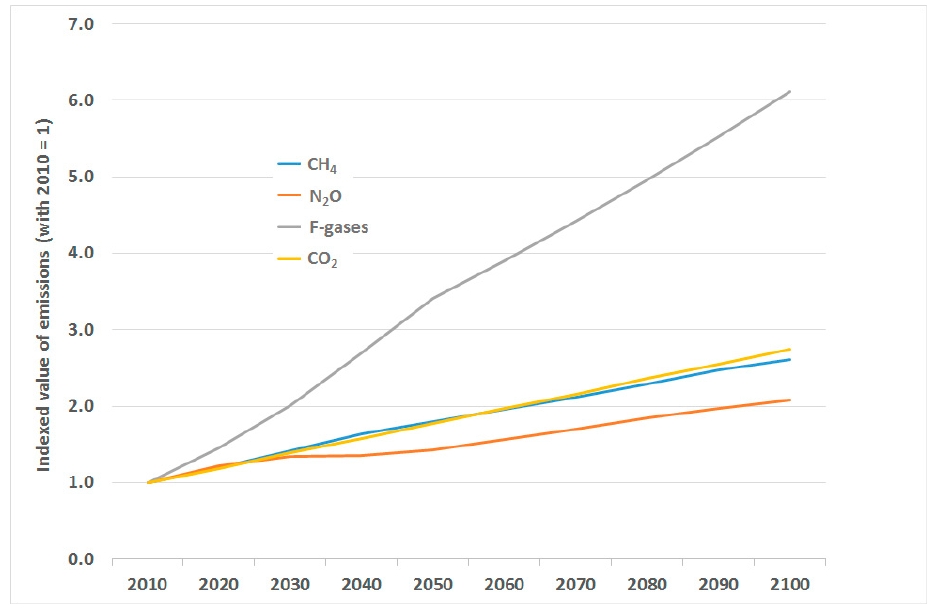
Figure A2. Increase in each GHG in the (unmitigated) reference scenario, indexed to its starting value in 2010 (which is given a value of 1).